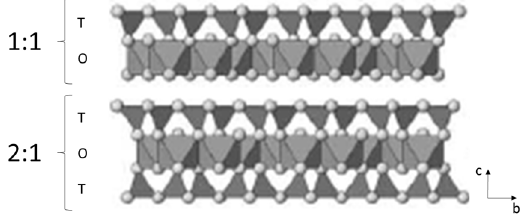
Figure 2. The representation of 1:1 (TO) and 2:1 (TOT) layer type with polyhedral model underlying the external surfaces of each type. Adapted from [21].